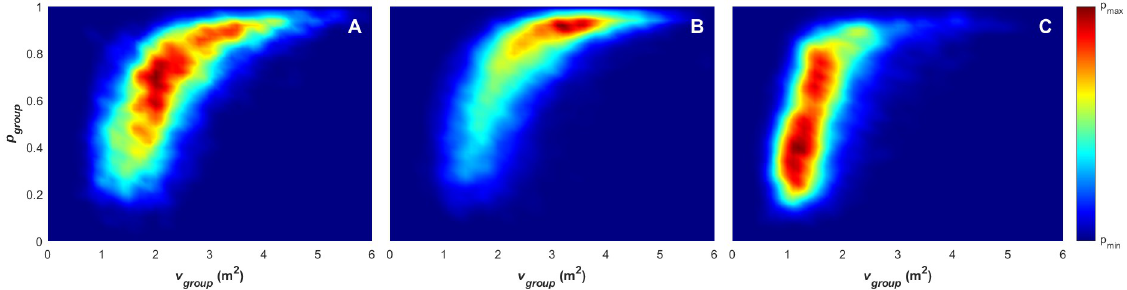
Fig 10. Density plots for paired mean group speed ( � u out-of-play (C) game